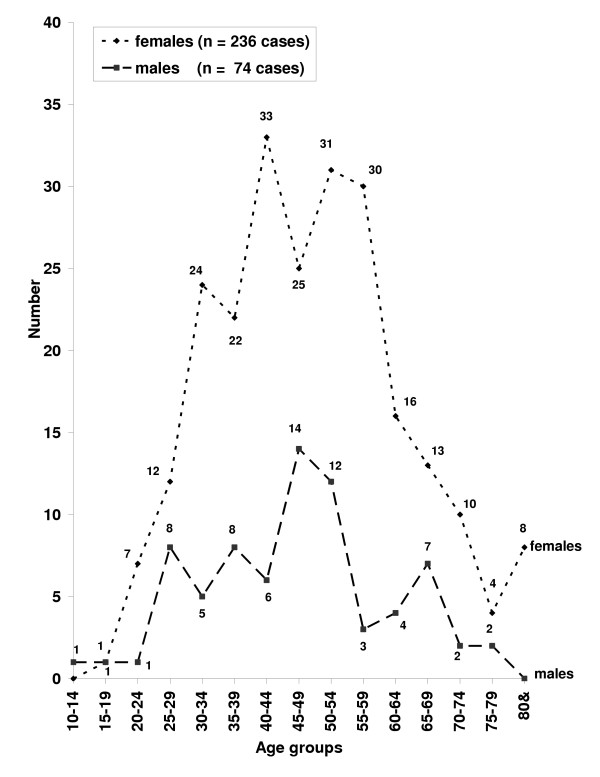
Age-distribution of the thyroid carcinomas (n = 310 cases); 1990–1999.